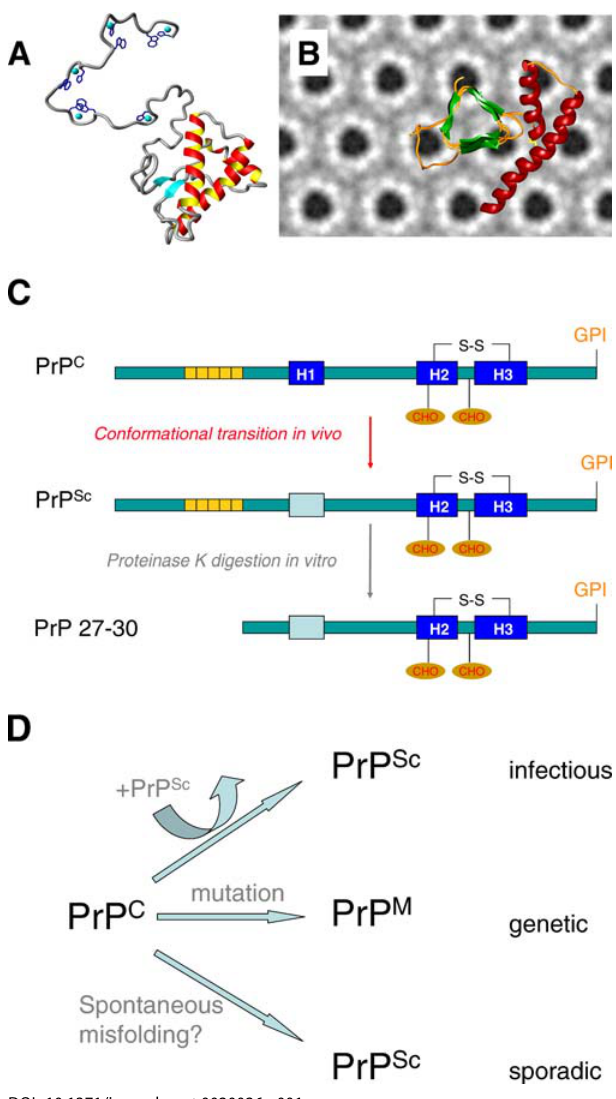
DOI: 10.1371/journal.ppat.0020026.g001 Figure 1. Formation of PrP Sc and Pathways to Disease (A–C) Structures of PrP C and PrP Sc . (A) NMR structure of PrP C with a notional addition of the N-terminal region (which is unstructured in NMR analyses). Copper ions (turquoise spheres) and coordinating side chains (dark blue) are shown. Note that the C-terminal globular domain has two short beta strands (turquoise arrows) and three a -helices (red; image courtesy of Glenn Millhauser, University of California Santa Cruz). (B) A structure for PrP Sc deduced from electron microscopic analyses of purified material. The background represents the two-dimensional crystals of PrP27–30 after image processing and the foreground a notional structure for PrP Sc with the central region of the protein rearranged into triangular stacked b -helices (image courtesy of Cedric Govaerts and Holger Wille, University of California San Francisco). (C) Linear representation of PrP C and PrP Sc , and N-terminal truncation of PrP Sc by proteinase K, to create PrP27–30. For illustrative purposes the conformational change in the centre of the molecule is shown by an altered color for helix A. Also note that other conformational changes may occur C-terminal to this position, but have been omitted for the sake of clarity. (D) Pathways to disease. In prion infections, conversion of PrP C to PrP Sc is initiated by a pre-existing seed of PrP Sc . In genetic diseases the mutant form of PrP C denoted PrP M may misfold and aggregate, and in some case acquire PrP Sc -like properties sufficient to initiate disease in inoculated recipient animals. In sporadic disease the mechanism of spontaneous misfolding to PrP Sc is